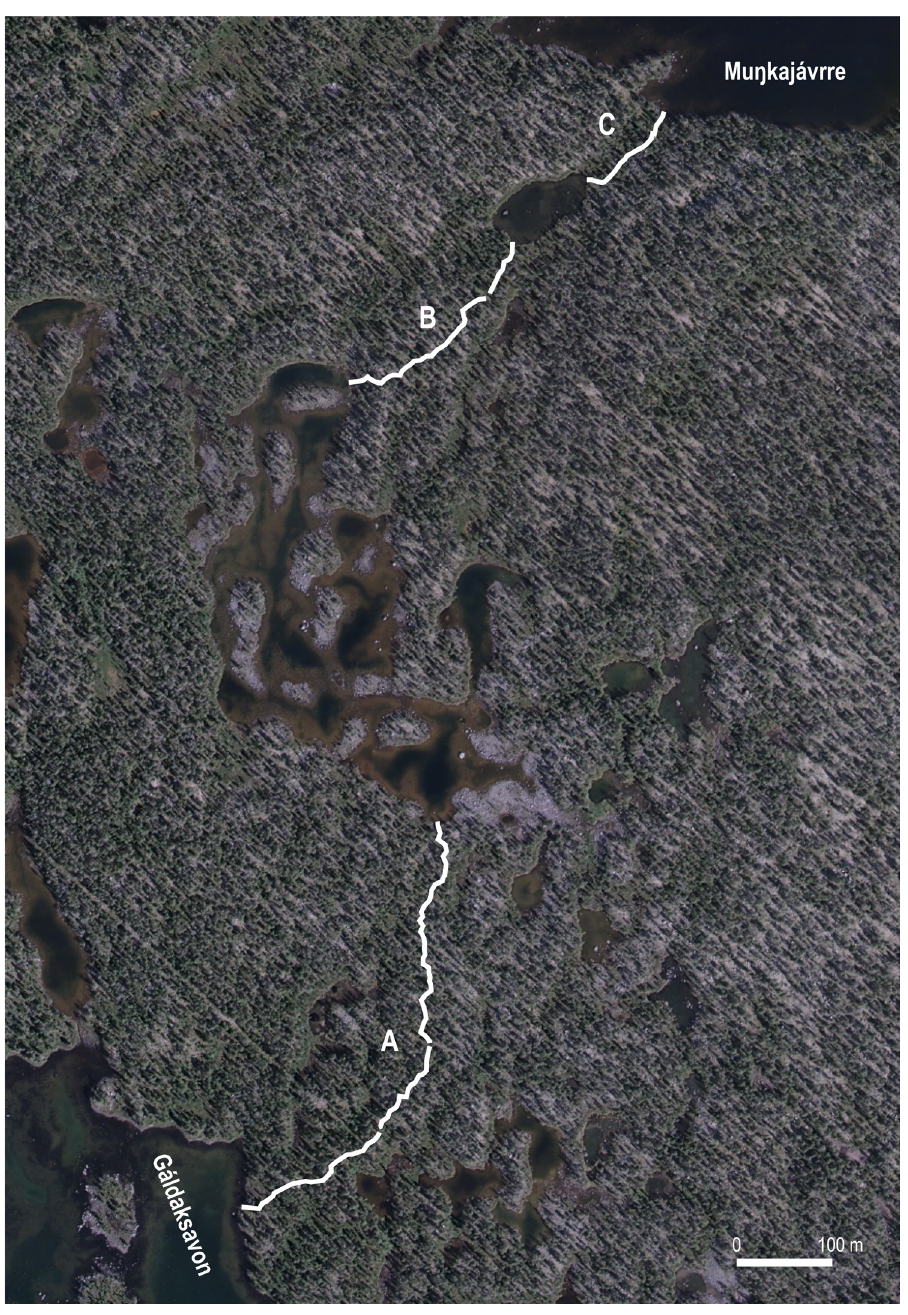
Figure 4. The three parts of the fence between Lake Mu ŋ kajávrre and Gáldaksavon (a part of the Pite River). Two unnamed lakes form part of the fence. Since the direction changes at almost every joint, the fence winds through the forest. There were three openings where no log remains could be found, two in part A (5.6 m and 3.2 m wide) and one in part B (6.4 m wide). ©